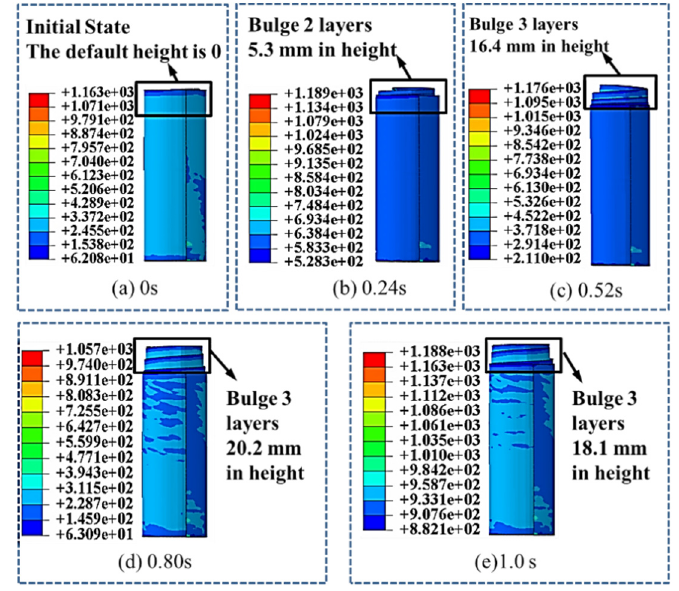
Figure 9. Evolution of top morphology of spring reel when the friction coefficient is 0.009 at ( a ) 0 s; ( b ) 0.24 s; ( c ) 0.52 s; ( d ) 0.80 s and ( e ) 1.0 s.